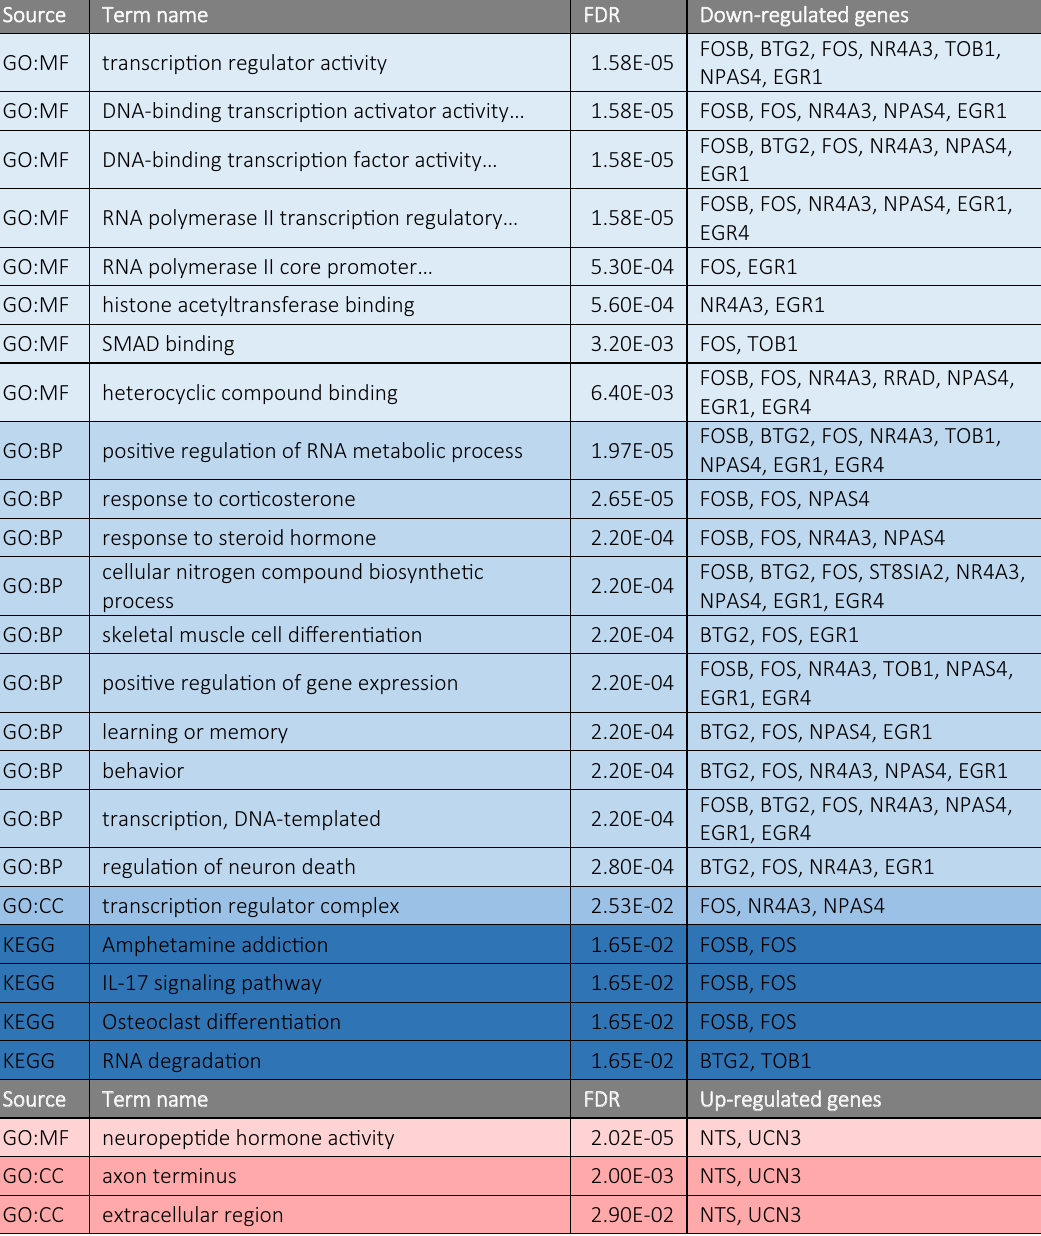
Table 1. Significantly enriched GO terms and KEGG pathways associated with down- or up-regulated genes in the hypothalamus. Only top 10 terms per category are shown. For MF and BP, filtering of terms for redundancy of enriched genes was done (maximum Jaccard similarity of 1 allowed). Several term names are cropped for space (see Supplementary Tables S4 and S5 for full list of unfiltered terms and complete term names). MF molecular function, BP biological process, CC cellular